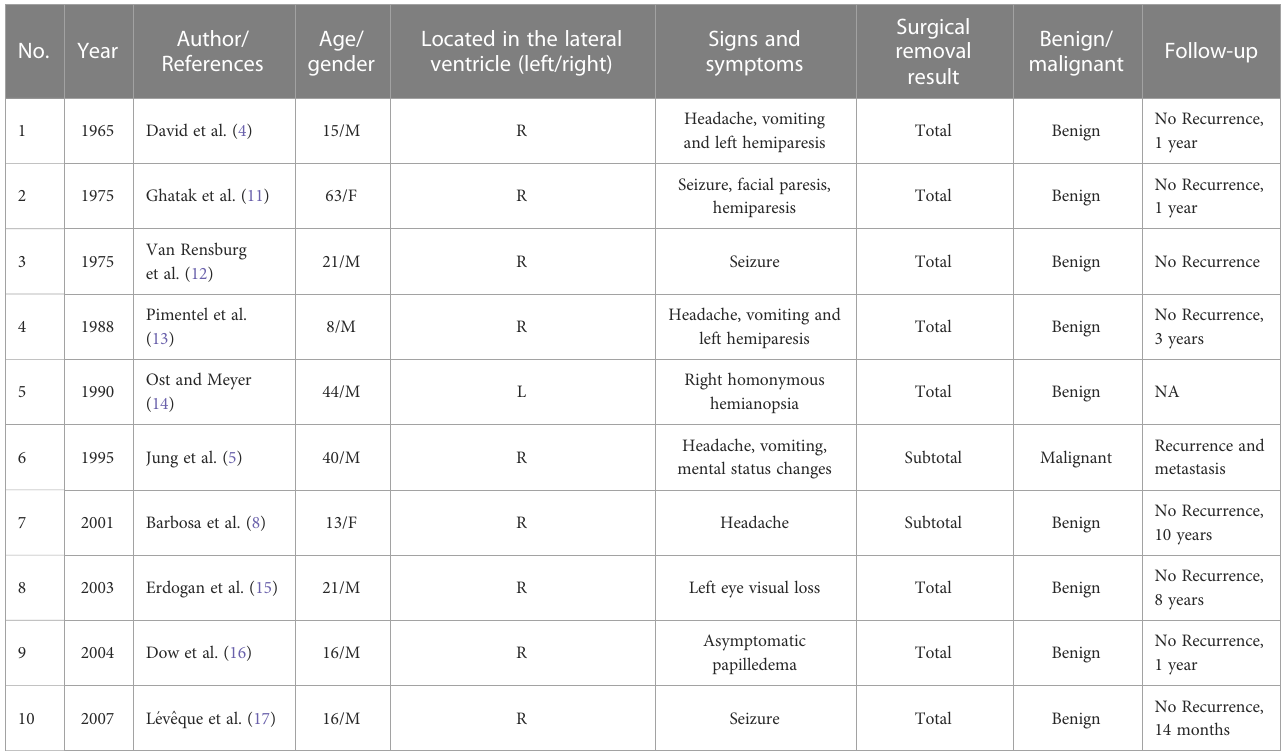
TABLE 1 LVES reported in the English